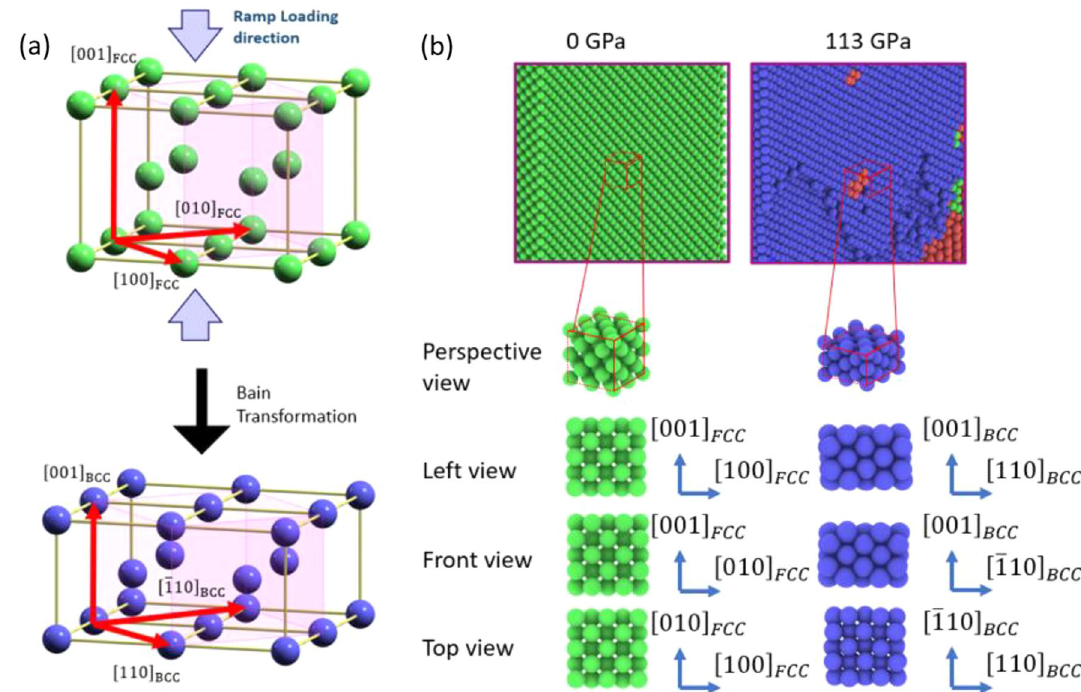
Figure 4. ( a ) Schematic of the Bain transformation and ( b ) Perspective, left, front and top views of a supercell that undergoes a structural phase transformation during loading at different stress and the corresponding lattice